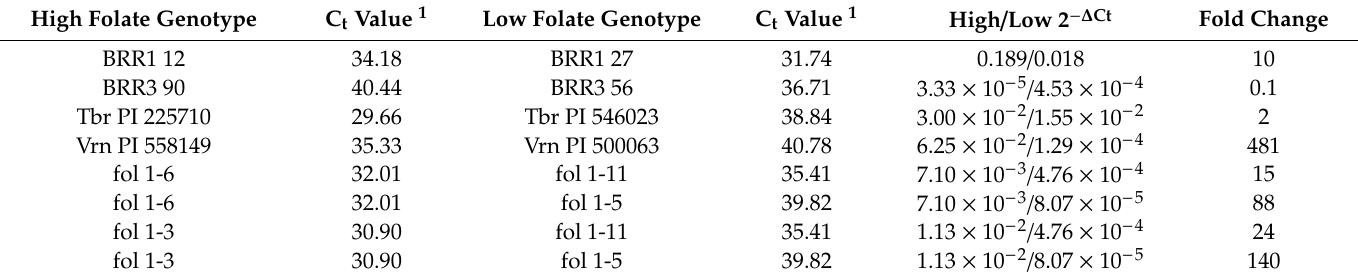
Table 4. Ct values, 2 − ∆ Ct values, and fold change in GGH1 expression in high and low folate genotypes as determined by real time quantitative RT-PCR